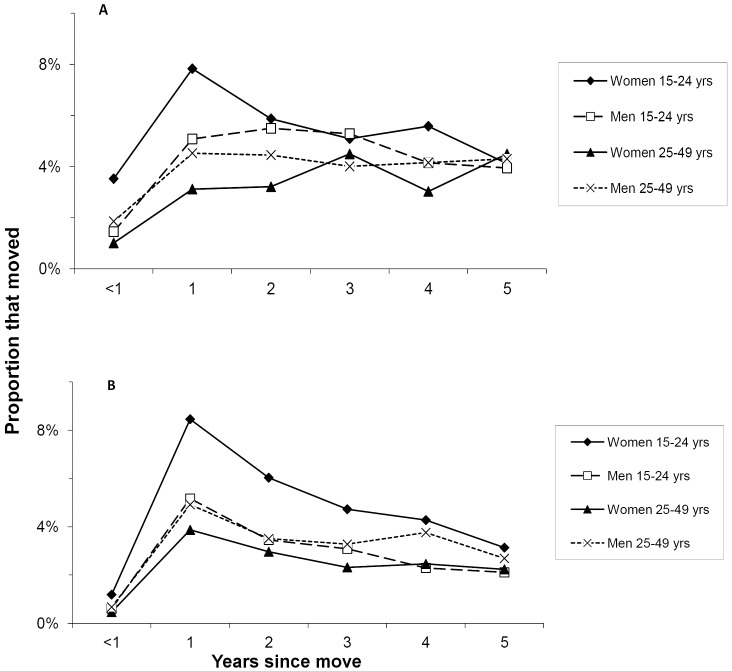
Prevalence of migration in Malawi, assessed in 2004 and early 2005.From the Integrated Household Survey [41]. (A) Rural to non-rural migration. Non-rural includes cities, towns and bomas (district administrative centres). N = 4,427. (B) Rural-to-rural migration. N = 17,722.